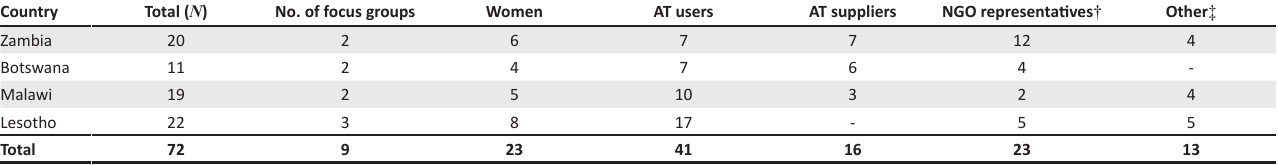
TABLE 1: Characteristics of focus group participants per country. Country Total ( N ) No. of focus